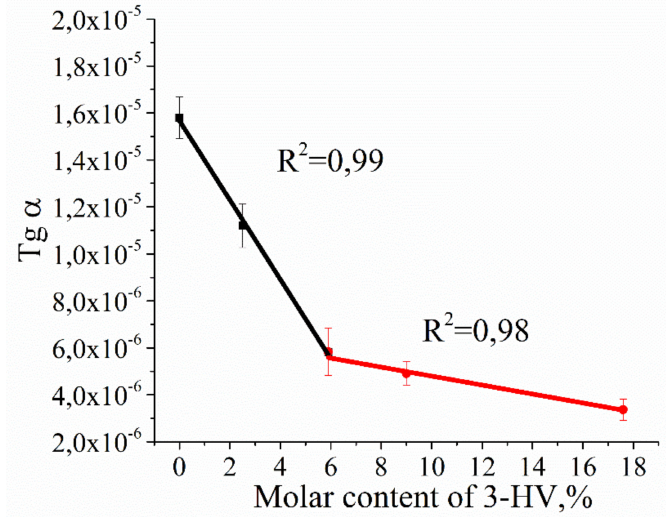
Figure 4. The graph of the slope angle on HV content for the not autocatalytic model of PHBV hydrolytic